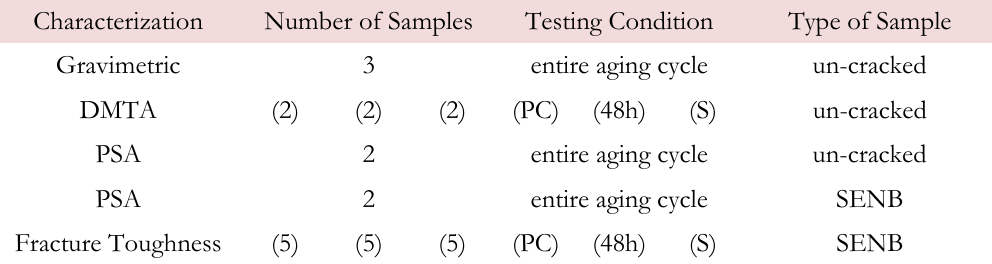
Table 1: Characterization methods and relative number and type of tested samples. PSA stays for Photoelastic Stress Analysis, and indicates the acquisition of three images (see the subparagraph on PSA). PC stays for postcured (not aged), 48h stays for aged in the thermal bath for 48 hours, and S stays for